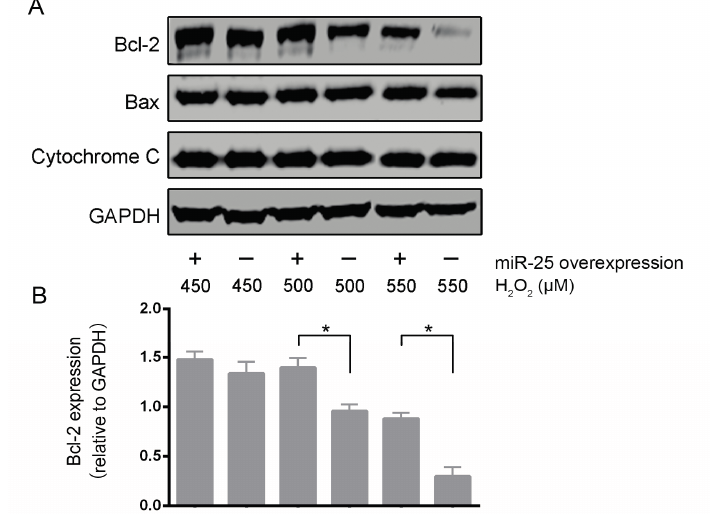
Figure 3. MiR-25 protected cardiomyocytes by inhibiting the mitochondrial apoptosis pathway. ( A ) Representative Western blot images showing the expression levels of Bcl-2, Bax and cytochrome C in H9c2 cells infected with miR-25 lentiviruses; ( B ) The quantitative data of the Western blot. GAPDH served as a loading control. Data are means ± SD from three independent experiments. * p <